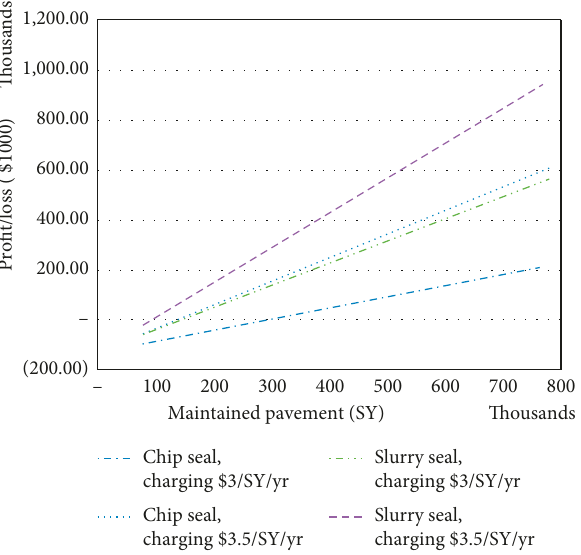
Figure 3: Profit/loss in implementing chip seals and slurry